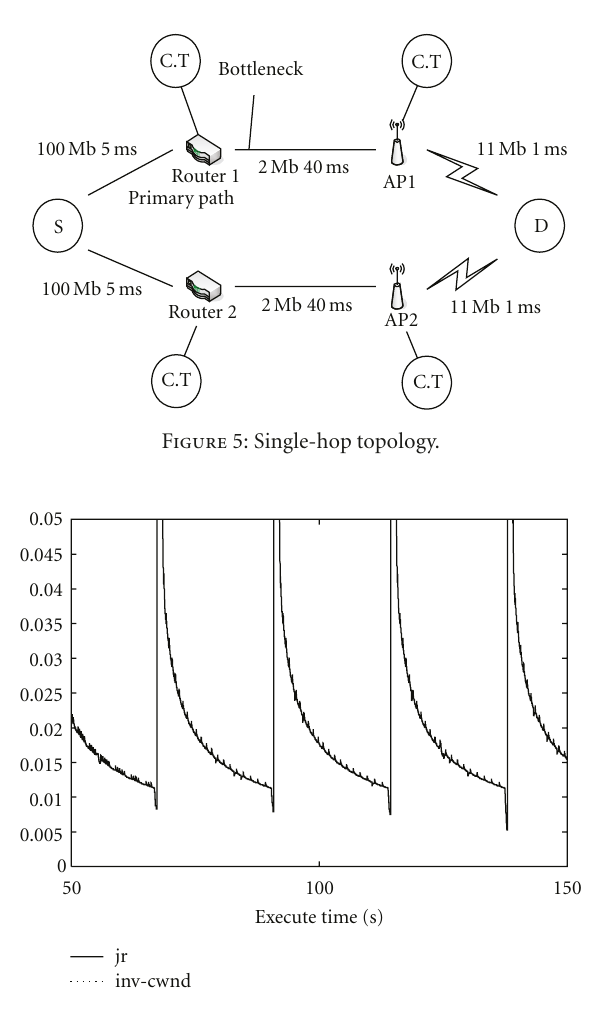
Figure 6: Comparison of filtered jitter ratio and k/w ratio.